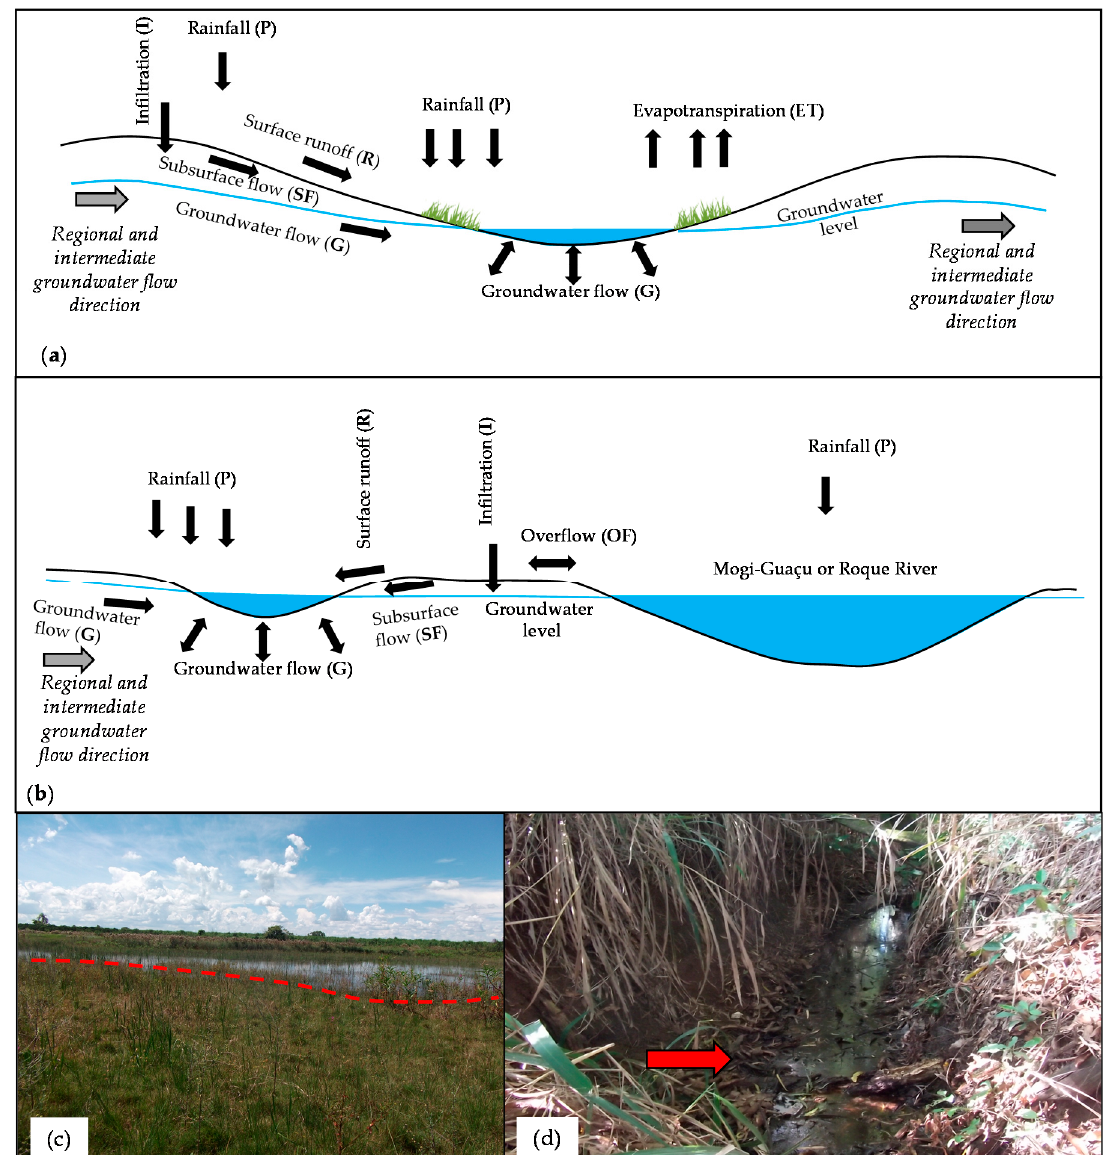
Figure 9. ( a ) Functional scheme of wetlands located in topographical depressions in high and plain positions of the terrain; ( b ) functional scheme of wetlands on topographical depressions in lowlands near or in the floodplains of the Mogi-Guaçú and Roque Rivers; ( c ) example of diffuse spring; ( d ) example of point spring.